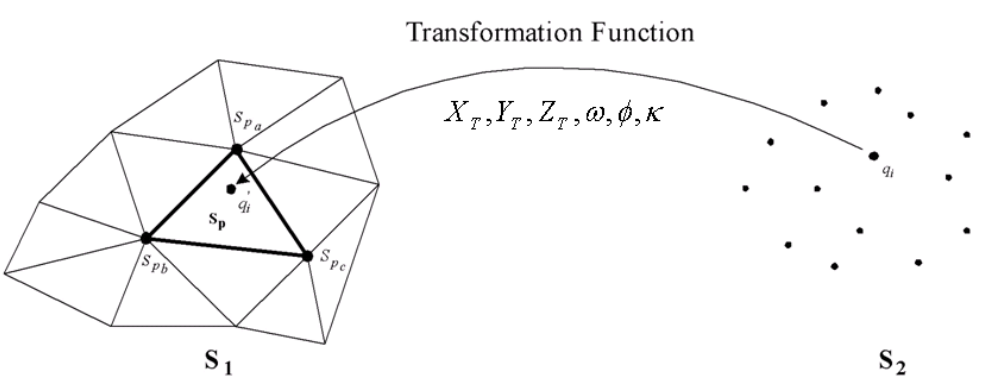
Figure 3. Conceptual basis of the proposed point-to-patch correspondence procedure.